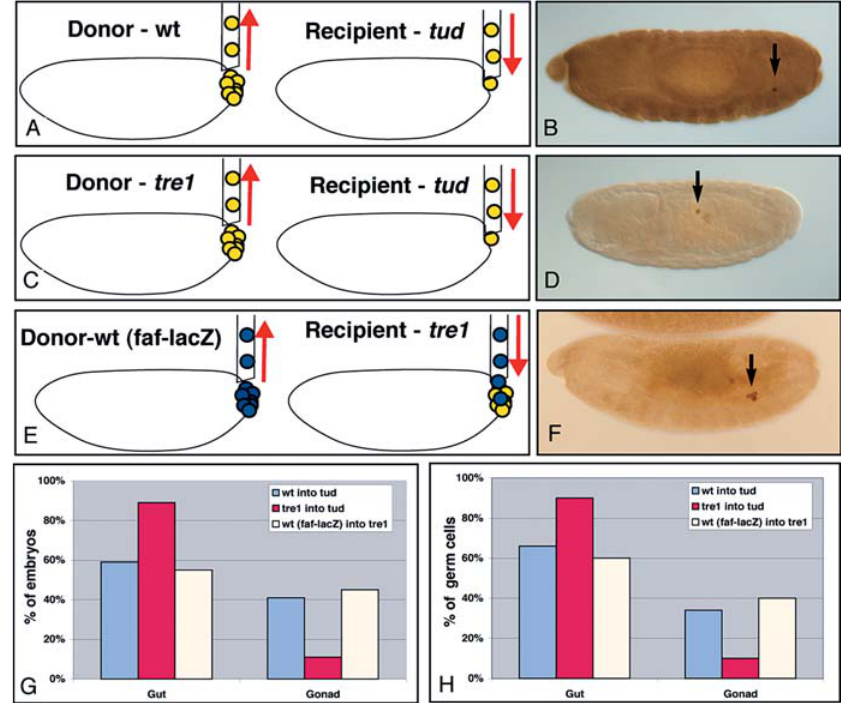
Figure 5. Germ Cell-Specific Requirement of tre1 by Germ Cell Transplantation (A), (C), and (E) depict the experimental scheme for germ cell transplantation. Germ cells (yellow) were transplanted from wild-type (A) or tre1 (C) stage 6 embryos to same stage embryos from tudor mothers, which do not have germ cells. In (E), germ cells (blue) labeled with LacZ ( faf– LacZ ) transgene were transplanted to the